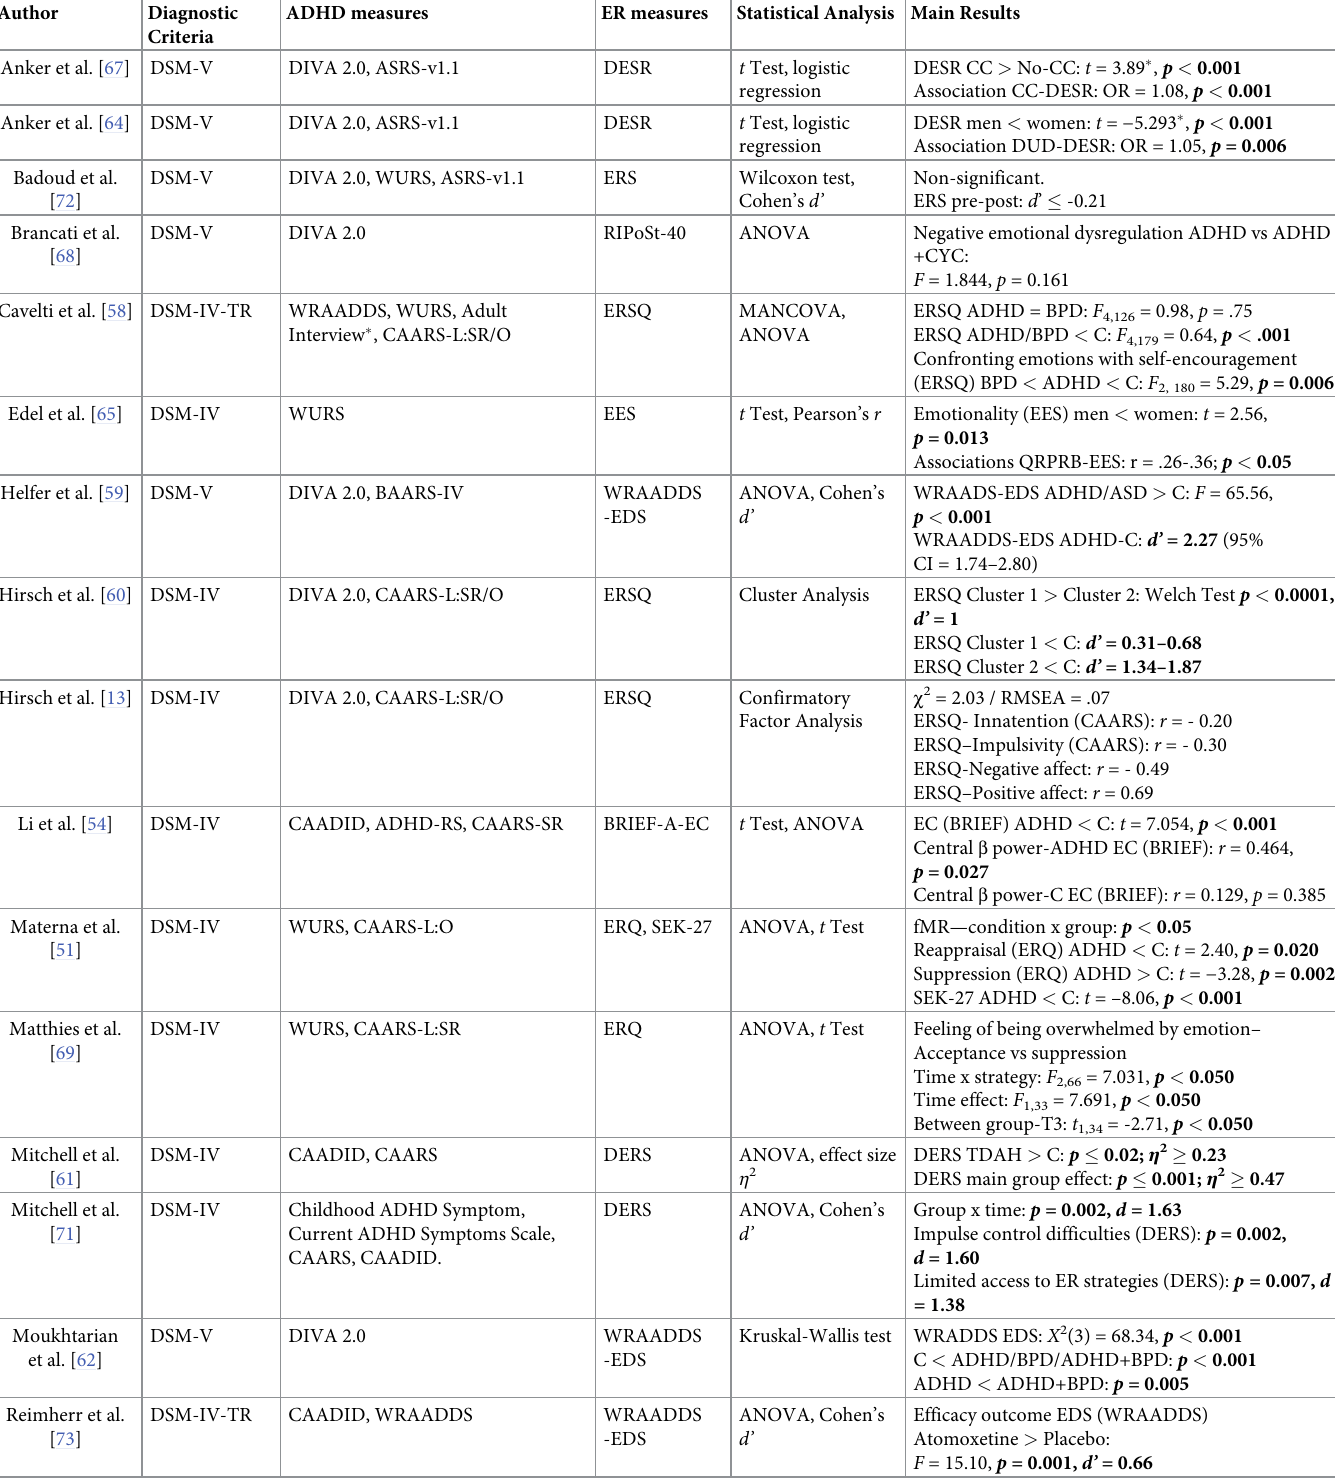
Table 1. Methodological information and main results of the reviewed